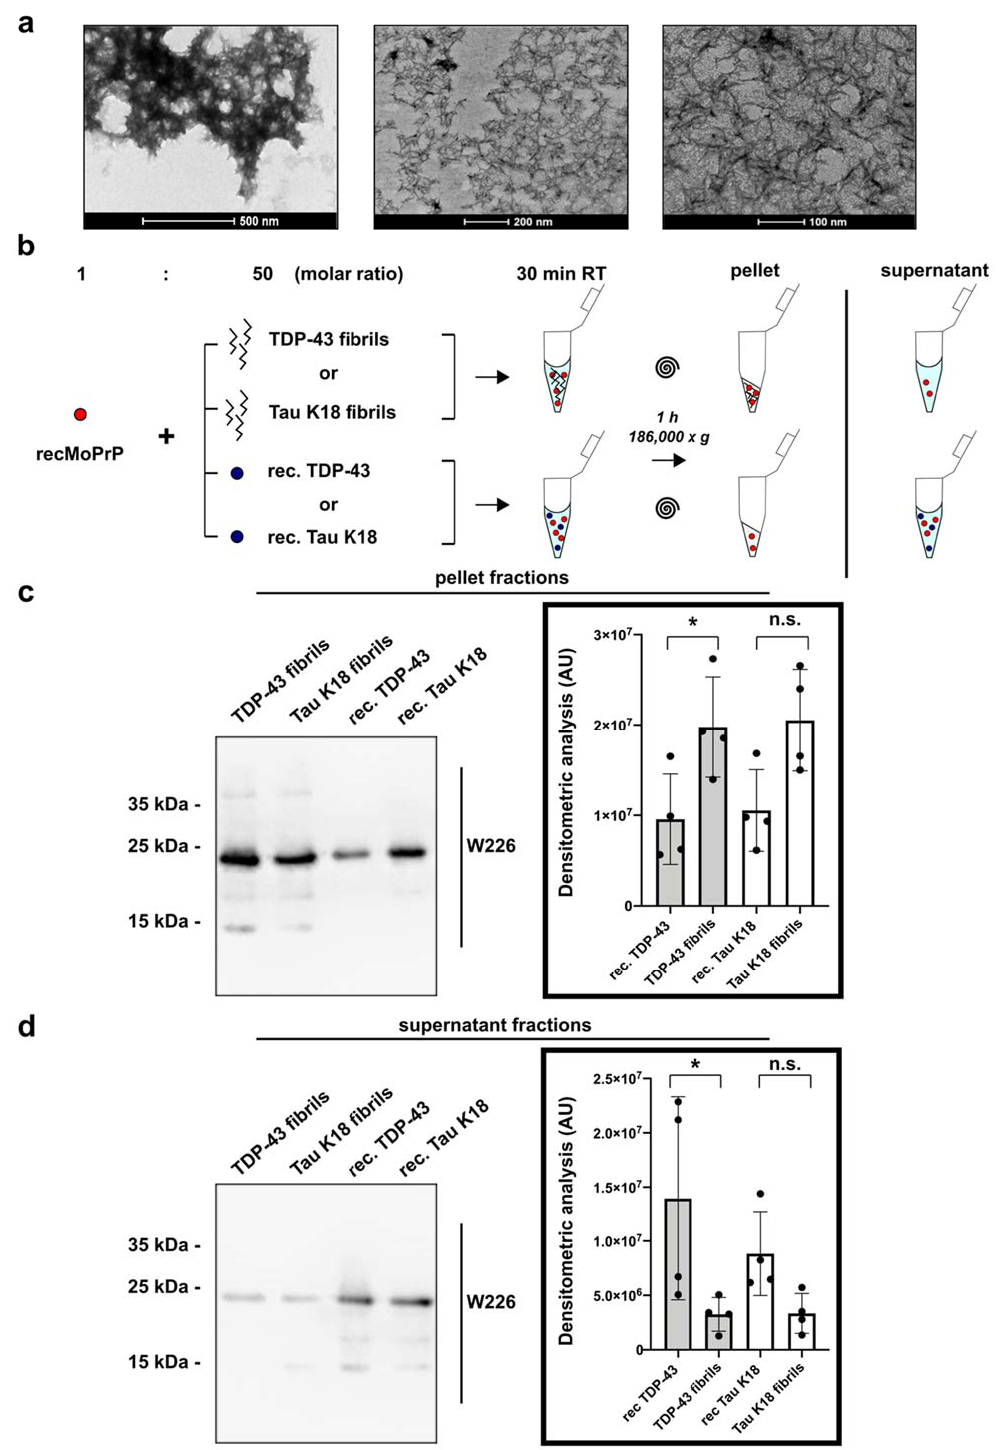
Figure 1. In vitro interaction between PrP C and TDP-43 LCD unseeded fibrils. ( a ) Transmission electron microscopy analysis of TDP-43 LCD unseeded fibrils collected when the reaction reached its plateau; ( b ) Schematic representation of the possible readouts for the in vitro assay designed to explore the binding between recombinant full-length mouse PrP C (recMoPrP) and TDP-43 LCD fibrils; ( c , d ) representative WB of the pellet and supernatant fractions collected after ultracentrifugation and analyzed with the anti-PrP W226 antibody; the right part of the image shows the graphs with the corresponding quantifications. Data were evaluated with Friedman test and Dunn’s multiple comparisons; * p < 0.05; n.s.: not significant. Data in the graphs are reported as mean ± SD; each dot represents an independent